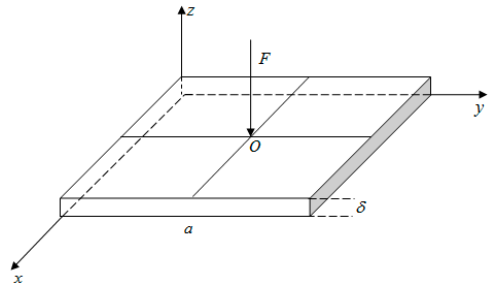
Figure 7. The analysis model of plate contact stress distribution function.